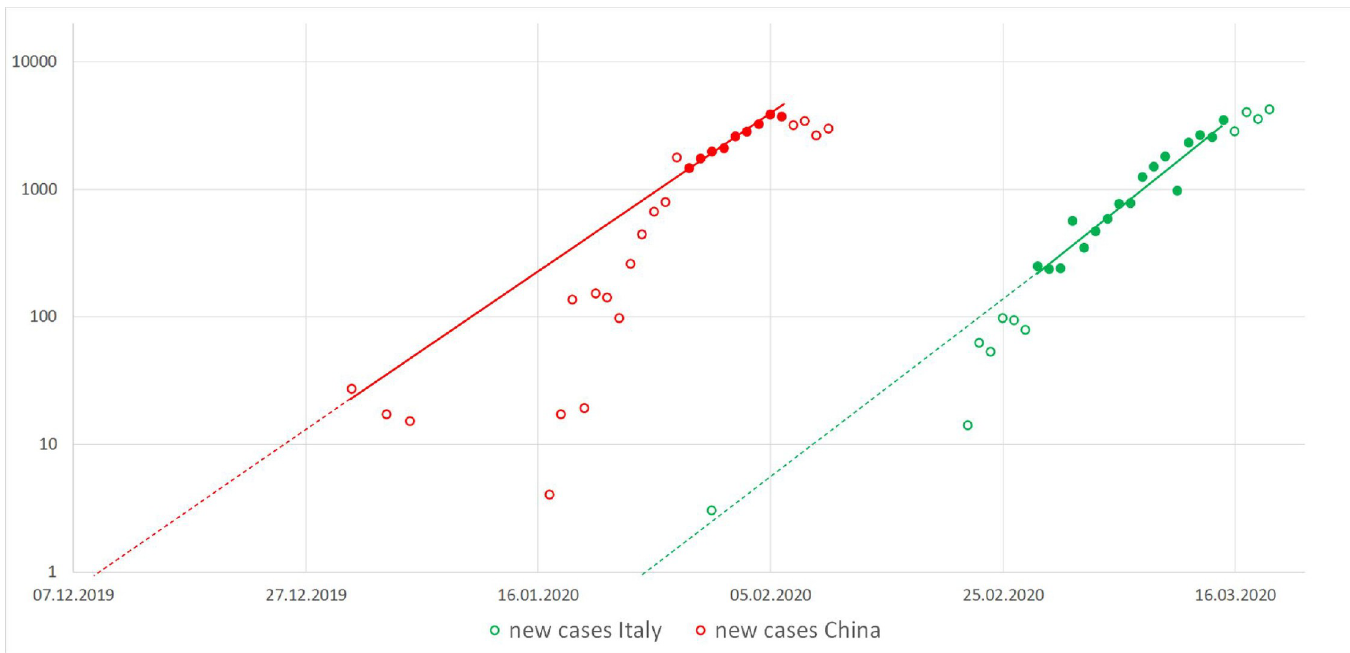
Fig 1. Log-liner plot of new cases. The linear period is represented by the dots identified by the semiautomatic process. Data represented by the full dots could be identified as exponentially behaved in contrast to the empty